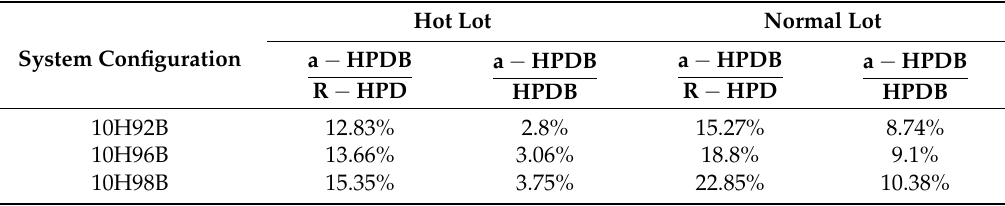
Table 2. The efficiency of a-HPDB under different bay-loading